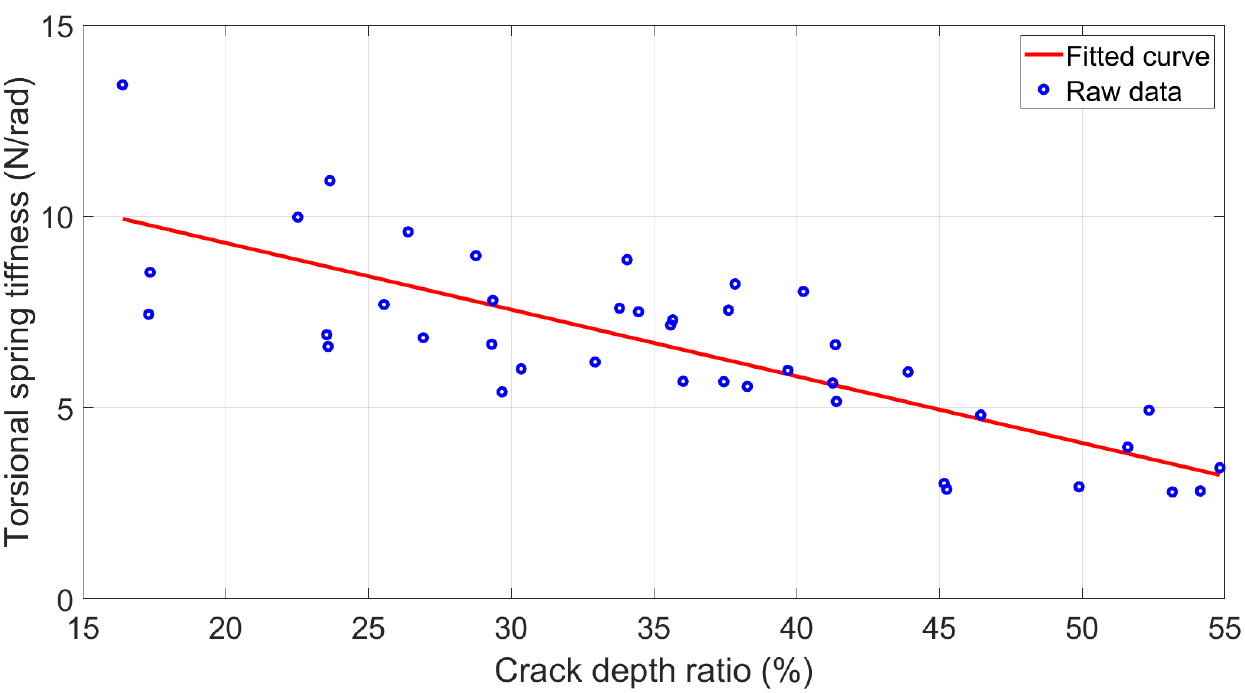
Figure 10. Regression model for torsional spring stiffness.